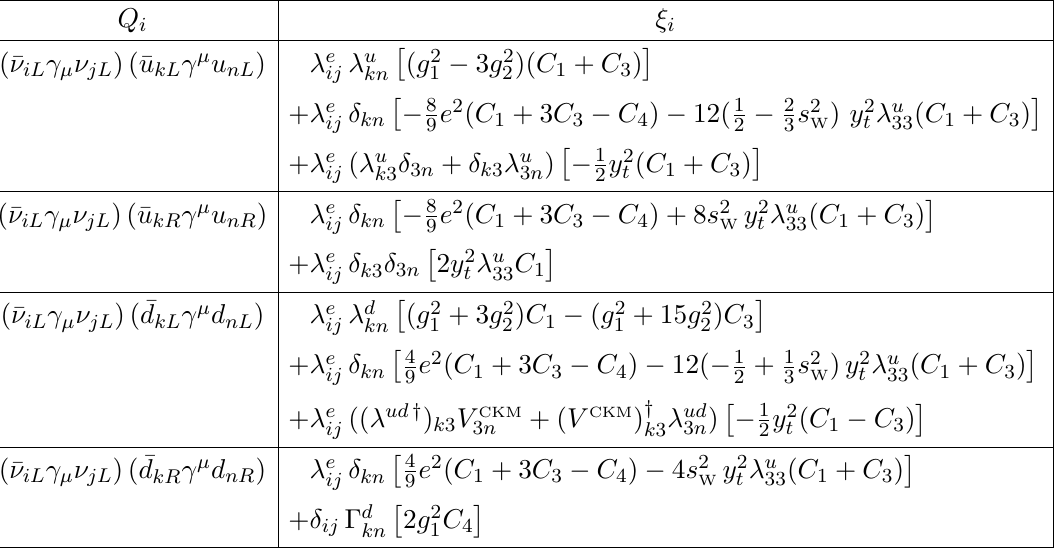
Table 3 . Operators Q i and coe(cid:14)cients (cid:24) i for the semileptonic part of the e(cid:11)ective Lagrangian L EW involving neutrinos and neutral currents. Generation indices run from 1 to 3, exception made for up-type quarks where k; n = 1 ; 2. We set sin 2 (cid:18) W (cid:17) s 2